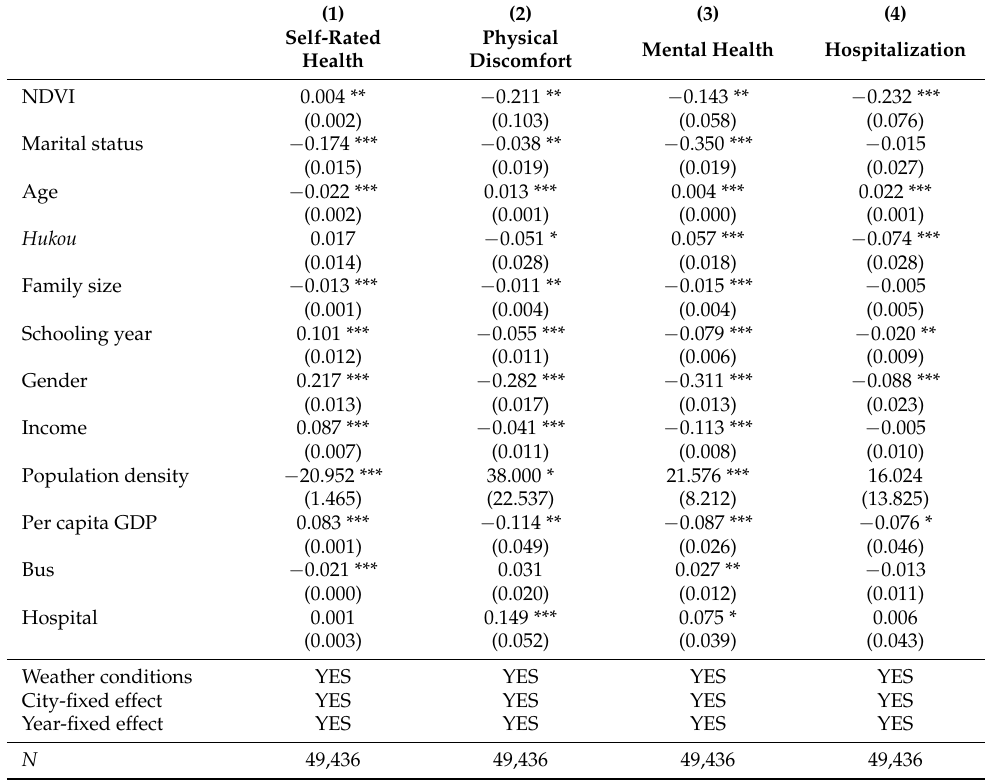
Table 2. Effect of greenspaces on individual